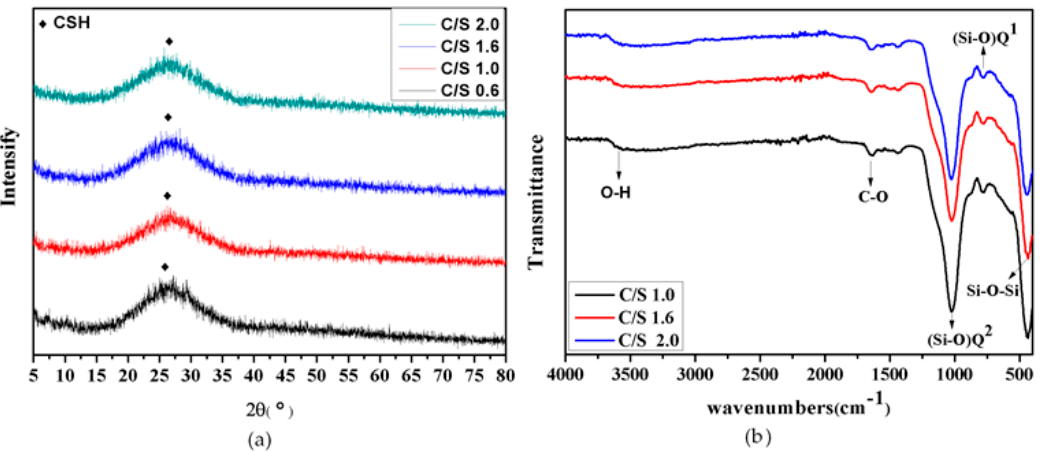
Figure 1. ( a ) Phase of CSH with different calcium silicon ratio, ( b ) infrared spectrum of CSH with different calcium silicon ratio .